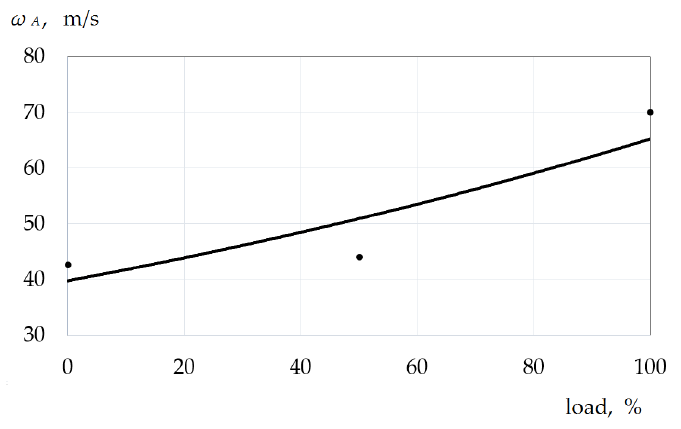
Figure 11. Dependence of average air velocity along the tracts on the load value.